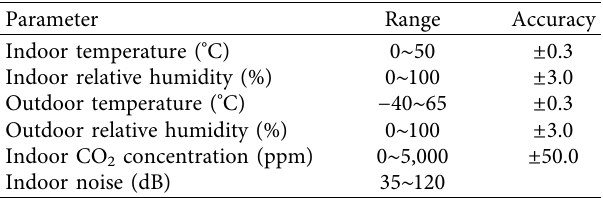
Figure 3: Test instruments: (a) window sensors, (b) Netatmo intelligent meteorological station, (c) open window state, and (d) closed window state. Table 2: Netatmo intelligent instrument environmental